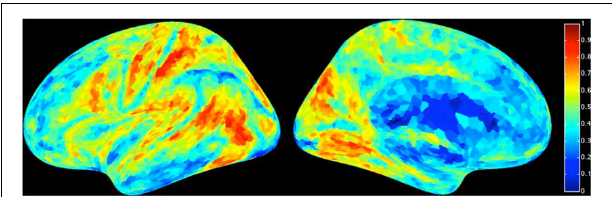
FIGURE 2 | Average global resting-state cortical correlation map from 20 subjects. Pseudo-color indicates the average cross-correlation of each voxel with the rest of the brain.